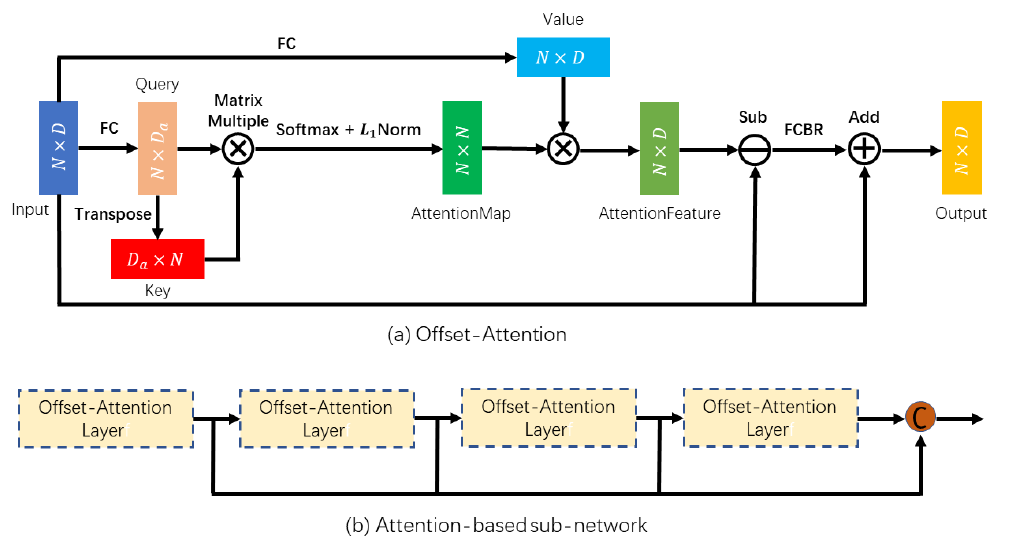
Figure 2. ( a ) is the description of offset-attention. ( b ) is the structure of attention-based